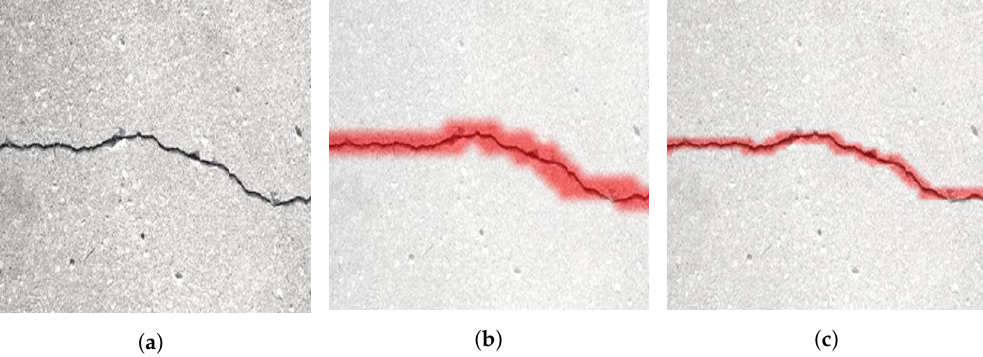
Figure 2. Resolution of mask representation comparison: ( a ) original image of concrete crack, ( b ) crack area representation by 28 × 28 mask (in red), and ( c ) crack area representation by 56 × 56 mask (in